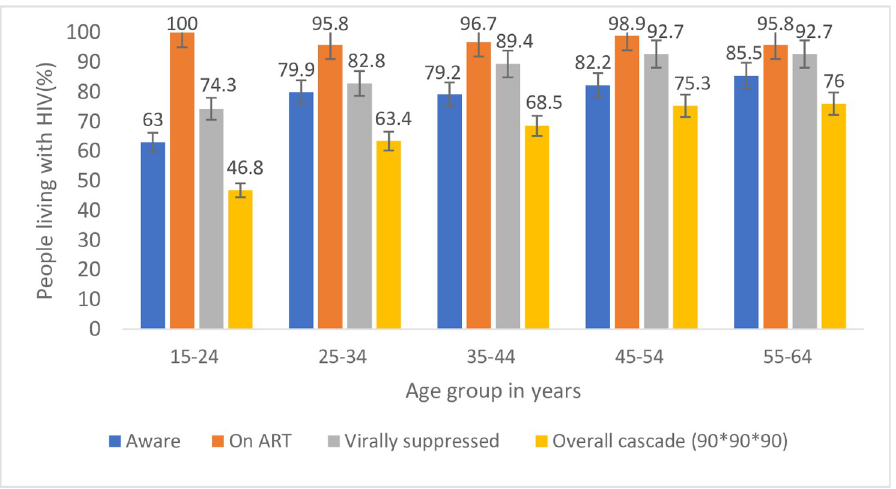
Fig 4. ARV adjusted conditional 90-90-90 targets achieved among adult participants by age, Ethiopia population- based HIV impact assessment, 2017–2018.